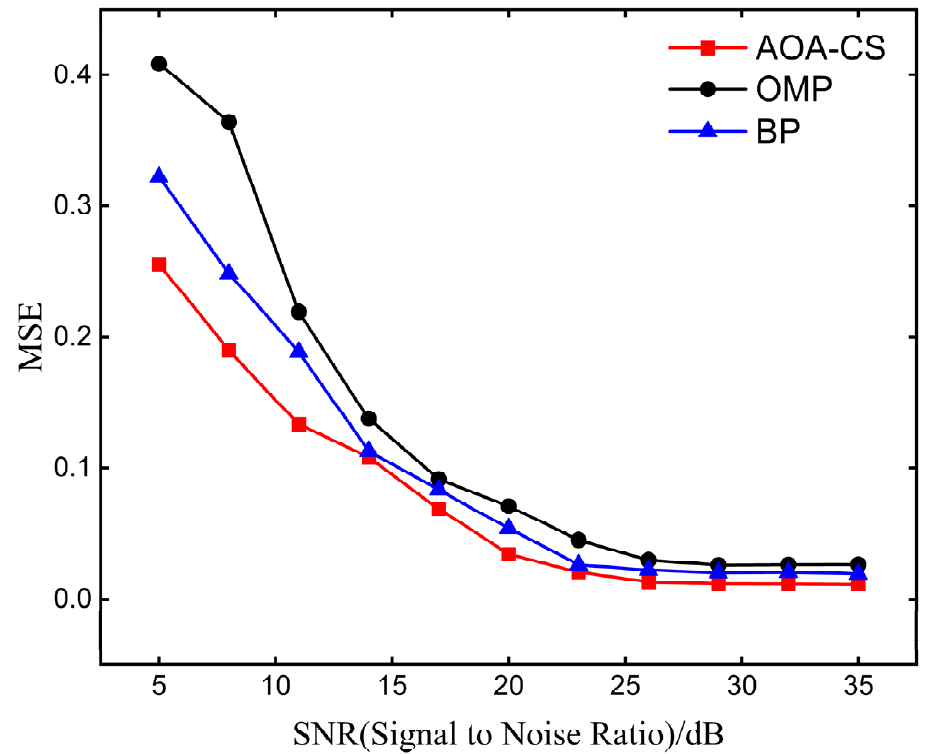
Figure 7. Reconstructed mean square error of AOA-CS algorithm in the presence of noise.